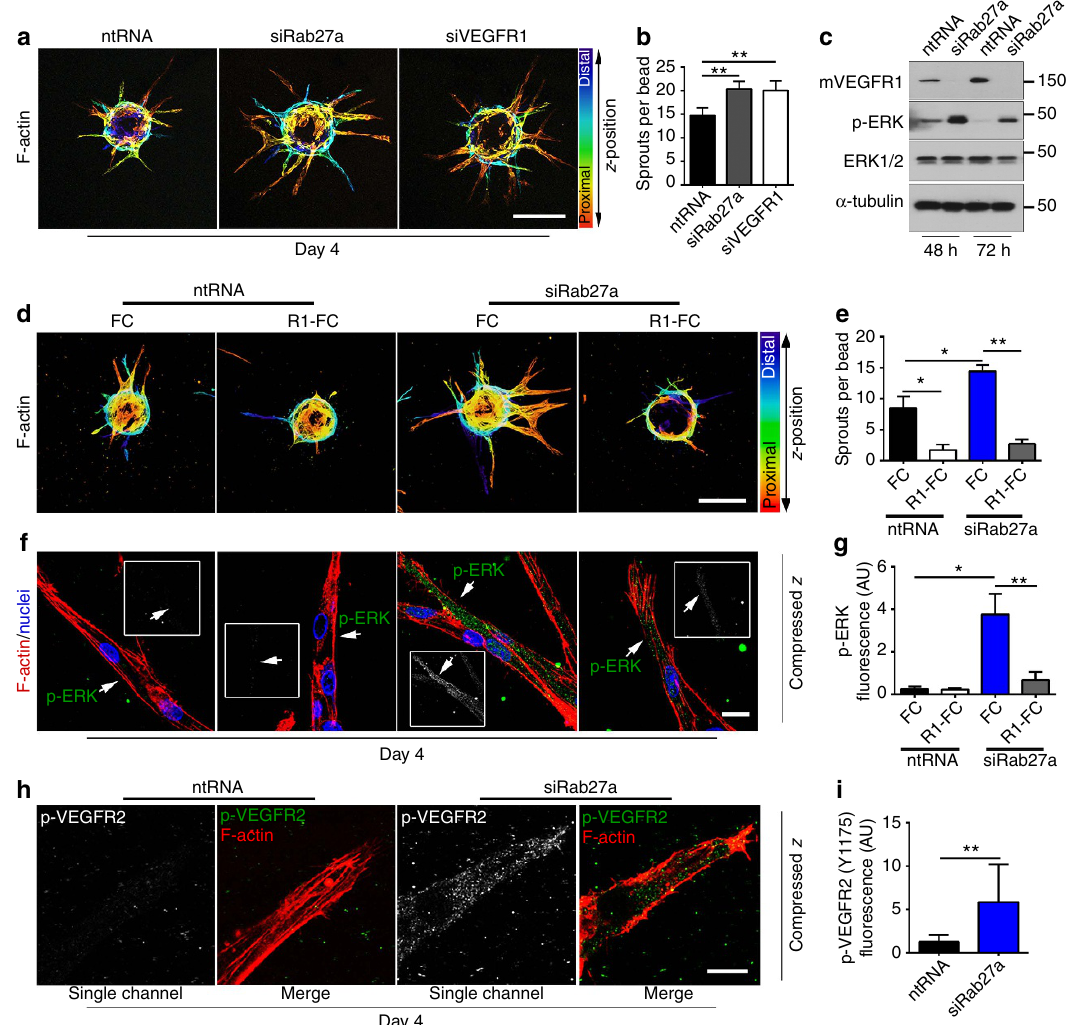
Figure 7 | VEGFR1 is epistatic to Rab27a. ( a , b ) ( a ) HUVEC angiogenic sprouts and ( b ) quantification of sprouting after indicated treatments, scale bar: 200 m m. (sprouts per bead, No. of beads: ntRNA ¼ 18; siRab27a ¼ 15; siVEGFR1 ¼ 16); three replicates. ( c ) Immunoblot of HUVEC with indicated treatments; three replicates. ( d – g ) ( d ) HUVEC angiogenic sprouts with indicated treatments, scale bar: 200 m m. FC, control; R1-FC, recombinant human VEGFR1. ( e ) Quantification of sprouts per bead. ( f ) pERK immunofluorescence of HUVEC angiogenic sprouts with indicated treatments, scale bar: 20 m m. ( g ) pERK quantification via integrated density. (pERK fluorescence, No. of sprouts: ntRNA/FC ¼ 8; ntRNA/R1-FC ¼ 9; siRab27a/FC ¼ 10; siRab27a/R1-FC ¼ 7; sprouts per bead, No. of beads: ntRNA/FC ¼ 14; ntRNA/R1-FC ¼ 14; siRab27a/FC ¼ 12; siRab27a/R1-FC ¼ 15); three replicates. ( h , i ) ( h ) pVEGFR2 (Y1175) Immunofluorescence of HUVEC angiogenic sprouts with indicated treatments, scale bar: 10 m m. ( i ) pVEGFR2 quantification via integrated density. (No. of sprouts: ntRNA ¼ 9; siRab27a ¼ 9); three replicates. Statistics: Shown are means þ 95% CI. One-way ANOVA and pairwise comparison with post-hoc Tukey’s range test. * P r 0.05; ** P r